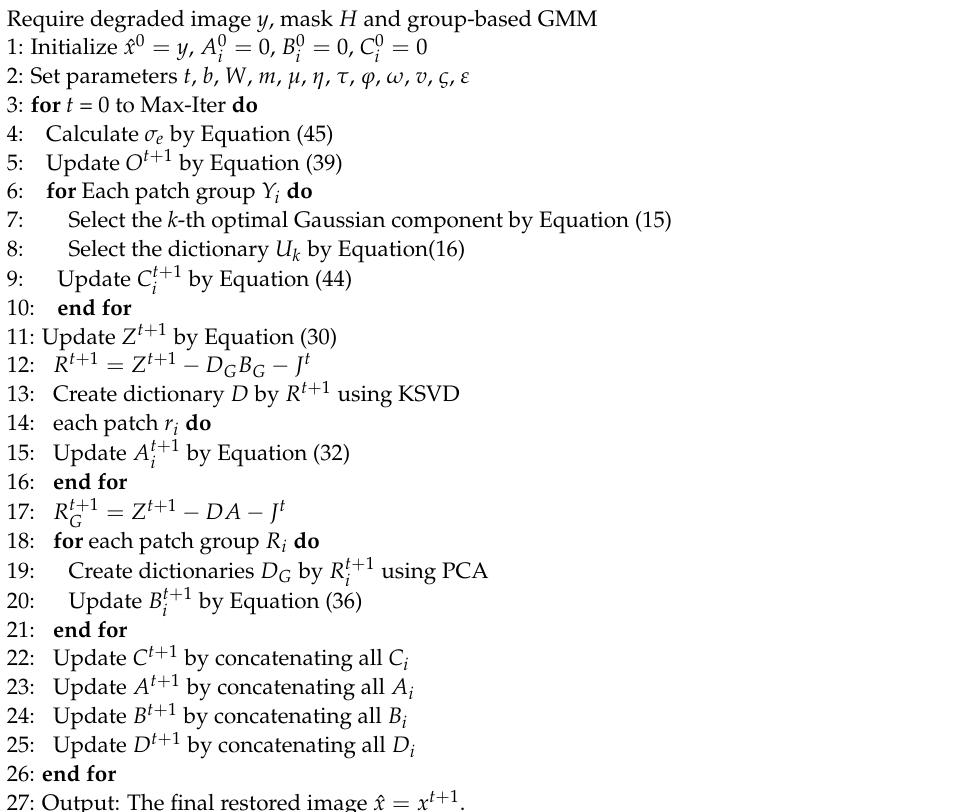
Algorithm 2. A hybrid sparse representation model for image